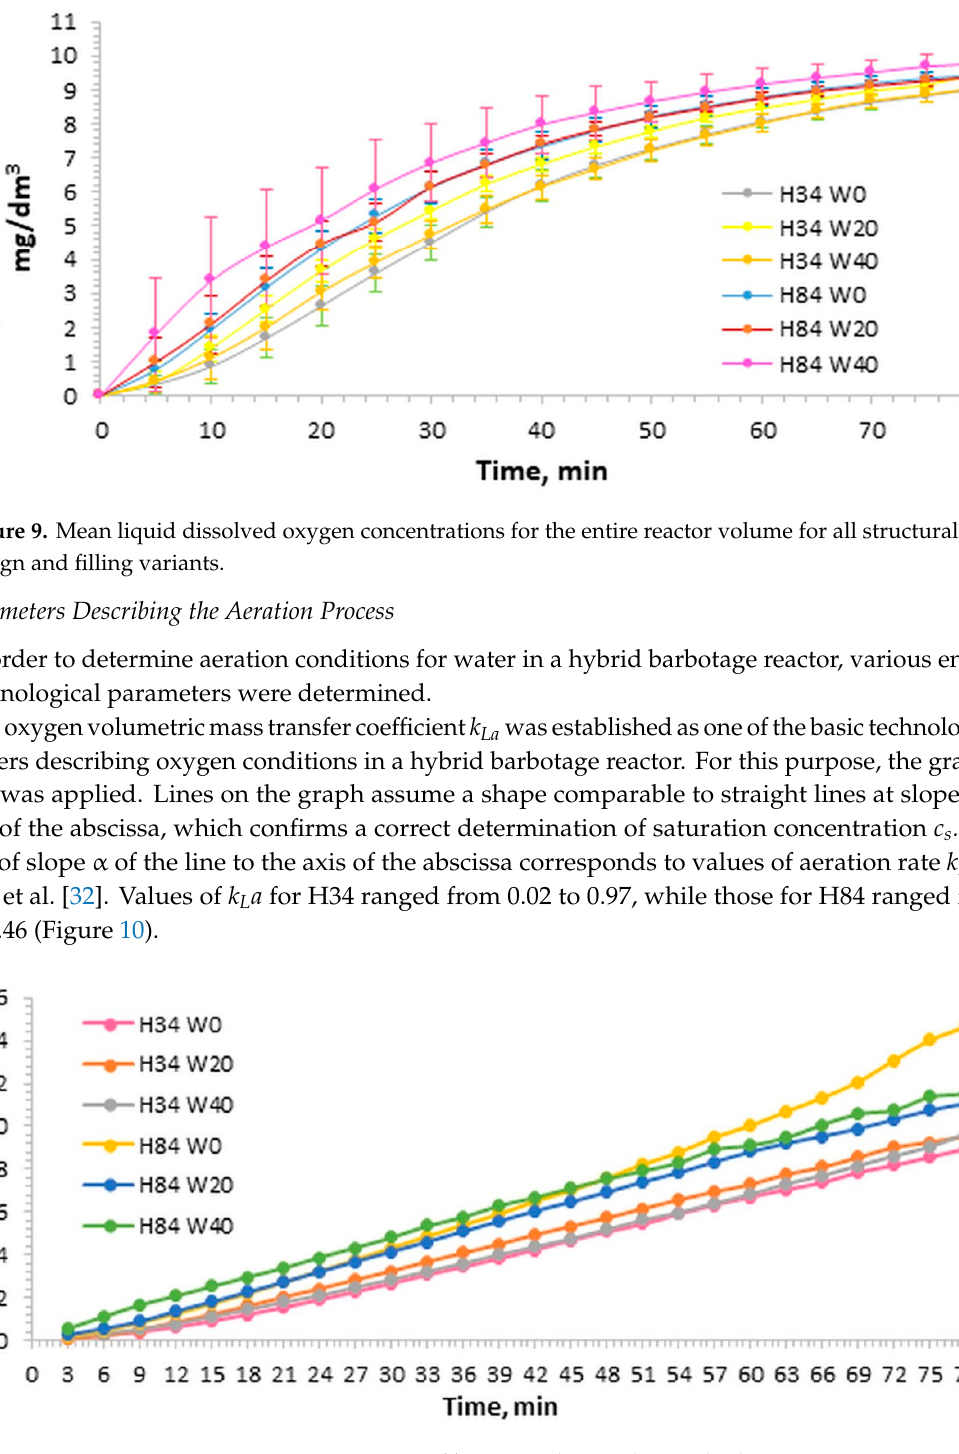
Figure 10. Determination of k L a using the graphic method.